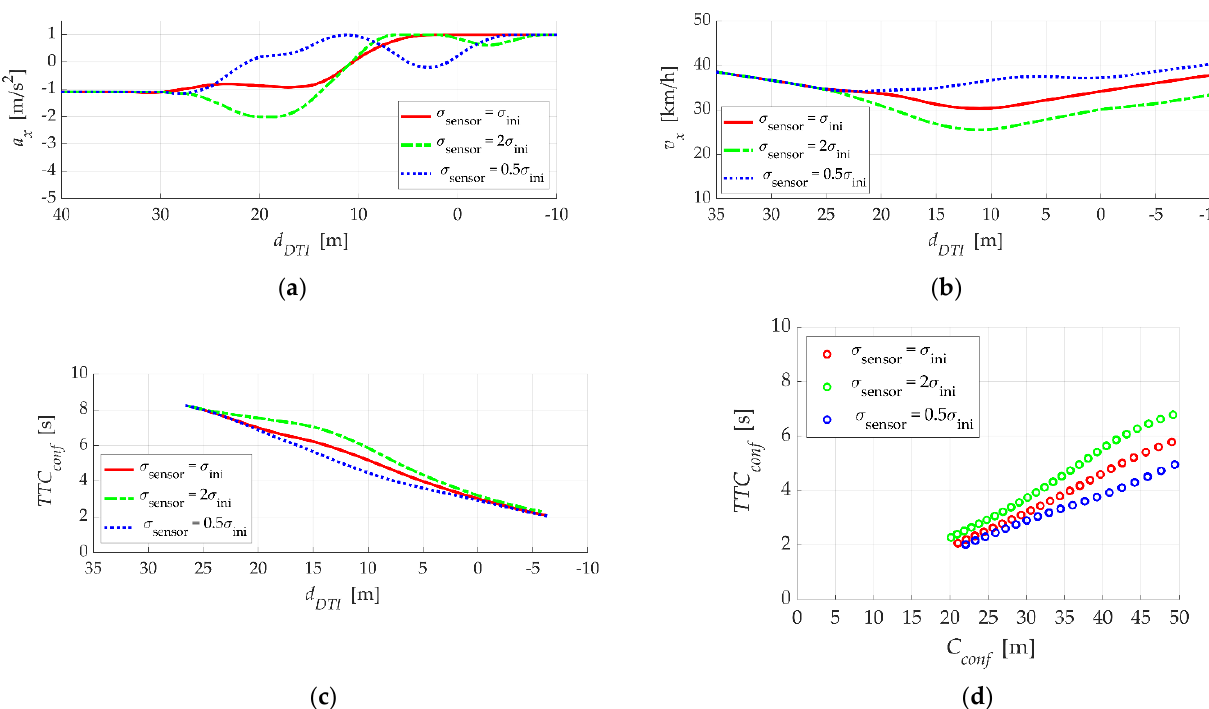
Figure 12. Simulation results of the proposed algorithm. ( a ) History of longitudinal acceleration; ( b ) history of longitudinal velocity; ( c ) history of TTC conf ; ( d ) trajectory of TTC conf and C conf .